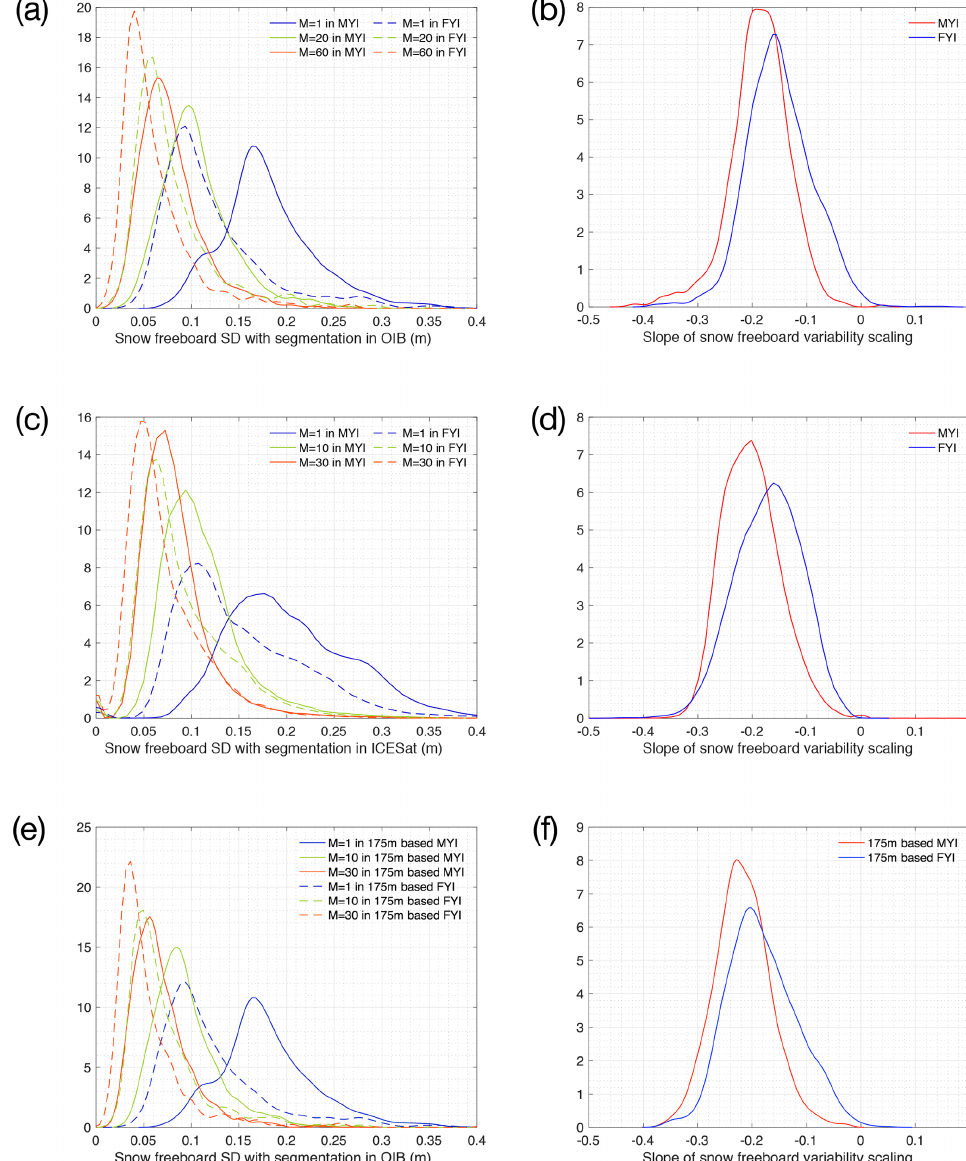
Figure 5. Variability in F s and its scaling for OIB (a, b) , ICESat (c, d) and OIB, with 175m interval (e, f) in the western